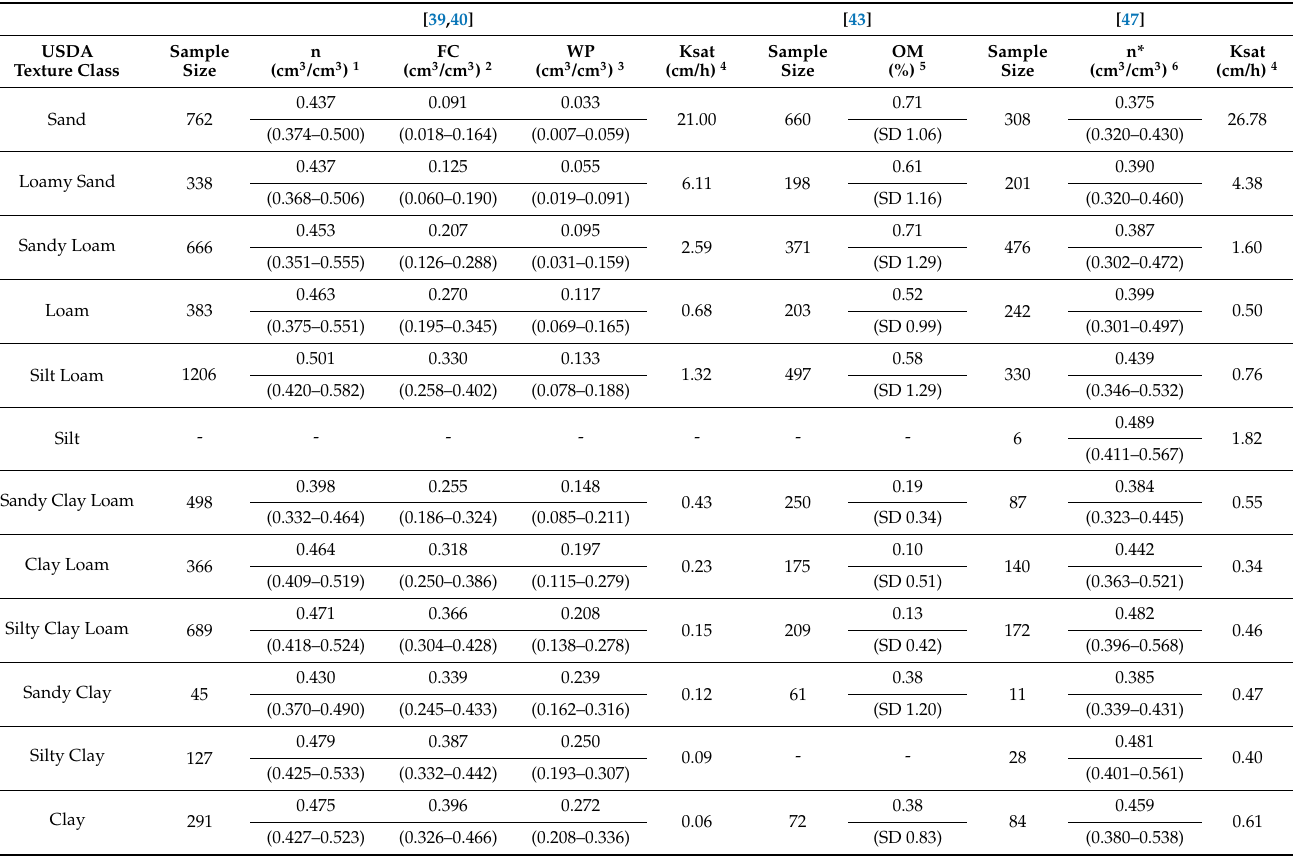
Table 1. Soil hydraulic properties variability for the USDA texture classes. Mean values are reported for each textural class, and ± 1 standard deviation values are in